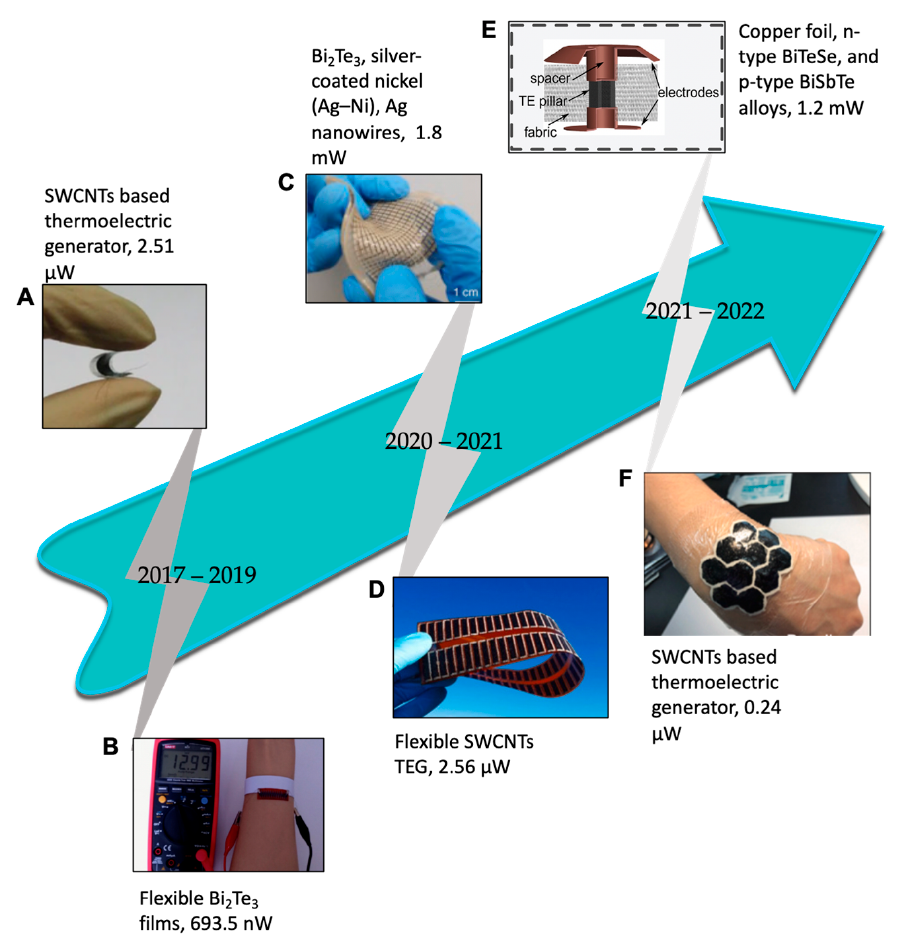
Figure 2. The advancement in the system architecture and the increase in power output of flexible TEGs within the last five years. ( A ) SWCNT-based TEG, reprinted from [18], copyright (2017), Zhou,